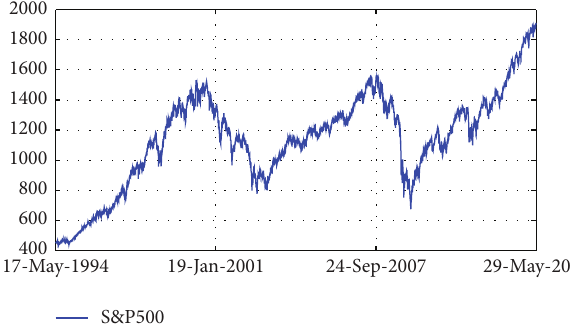
Figure 1: Daily observations of S&P 500 from 1994 to 2014.